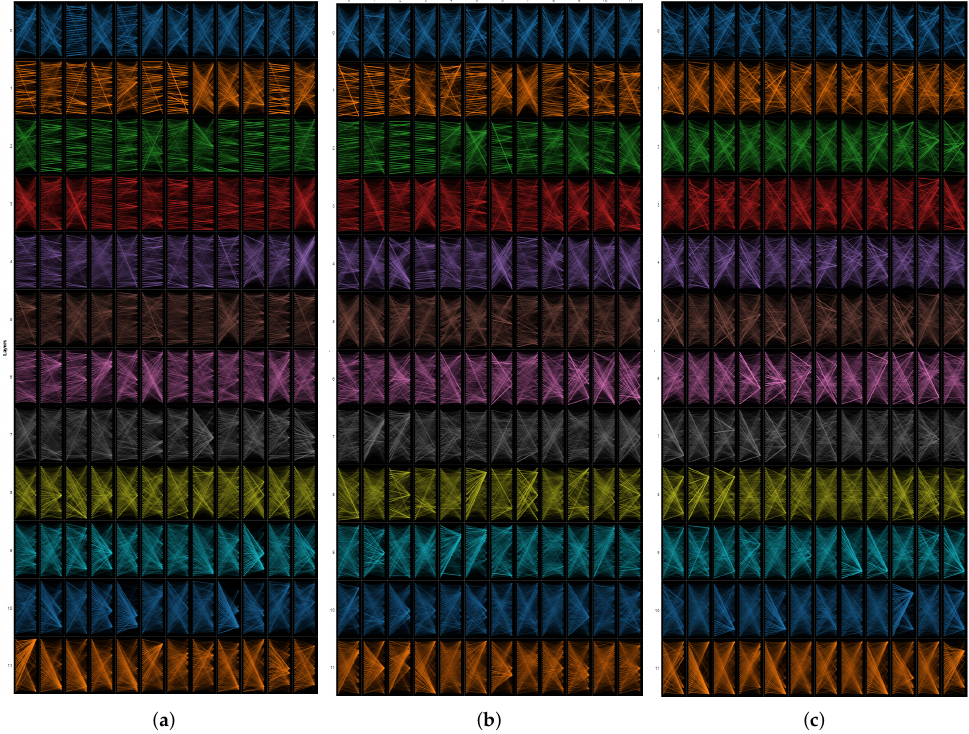
Figure 11. Self-attention mechanism in GeoBERT. GeoBERT consists of 12 layers and 12 heads in each layer. Each row represents a layer (from 0 to 11). Each block represents a head (from 0 to 11). The lines between pairs of tokens in a head show the self-attention weights between them. The darker the color is, the greater the weight between the two tokens. Different layers are represented by different colors, while the same color represents heads in the same layer. These are better viewed in